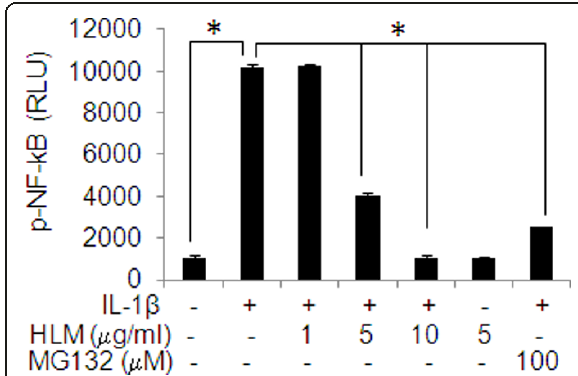
Figure 6 Effect of HLM ( Uncaria tomentosa ., Boswellia spp ., Lepidium meyenii and L-Leucine ) on the IL-1 b -induced activation of NF-kB in IL-1 b -stimulated OA chondrocytes . Chondrocytes were transfected with NF-kB luciferase plasmid and the NF-kB dependent transcriptional activity was determined by luciferase assay using commercially available kit (Promega). Value represents Mean ± SD of three different experiments repeated in duplicate. * p <